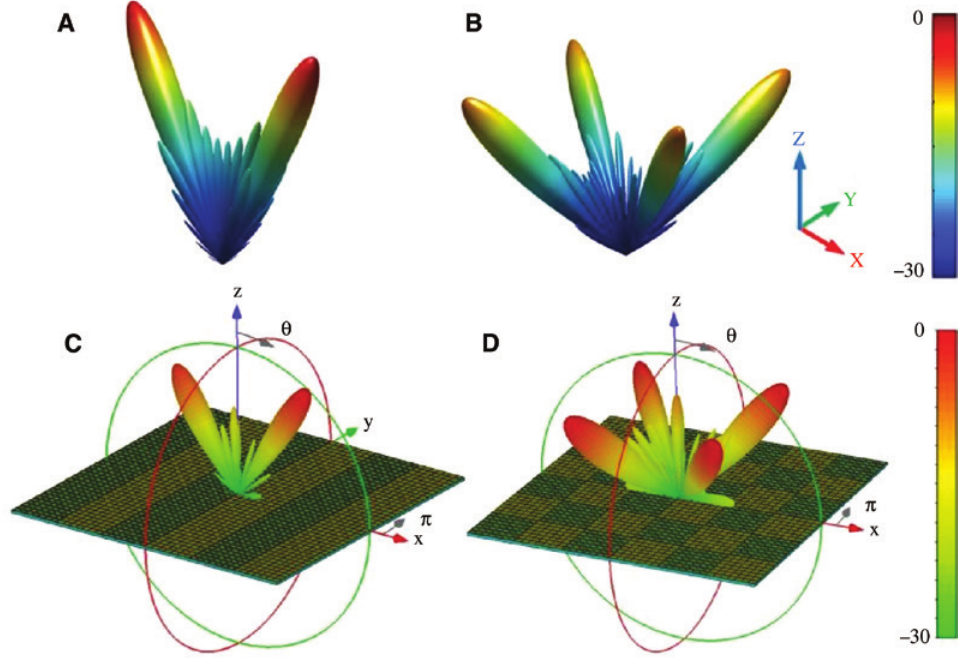
Figure 4: Far-field radiation patterns of the 1-bit reflection-type information metasurfaces shown in Figure 1 to show the ability in controlling the scattering patterns by two different coding